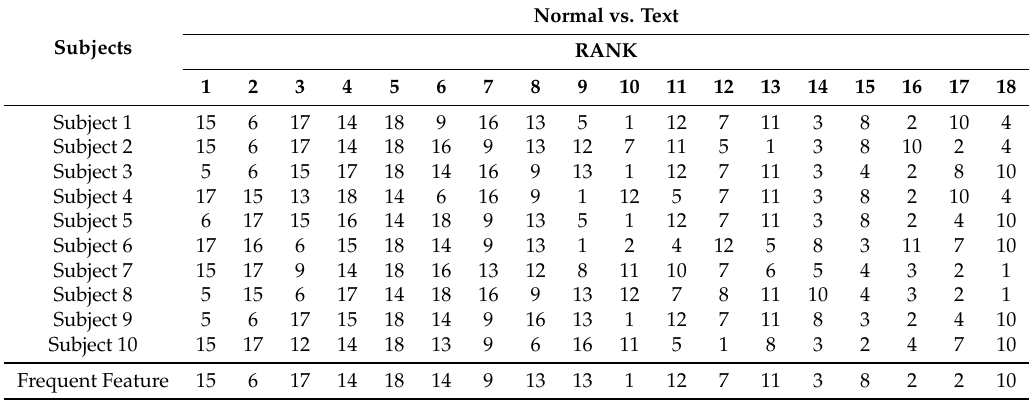
Table 5. Support vector machine-recursive feature elimination (SVM-RFE) feature ranking for normal vs.